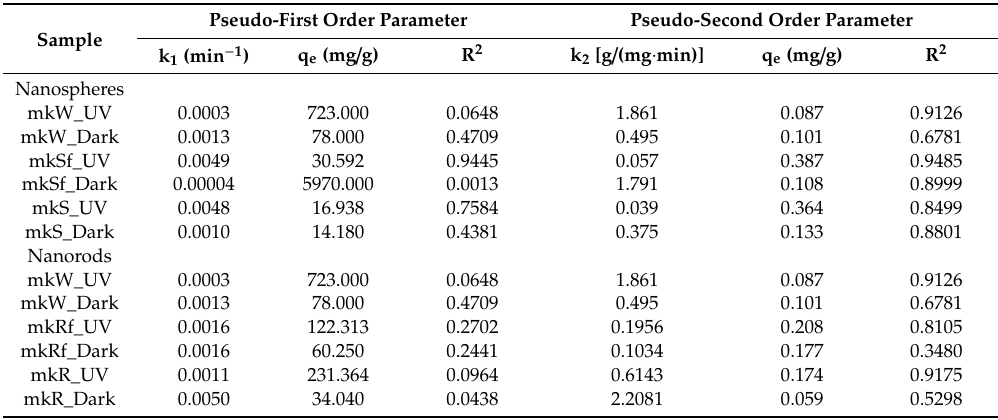
Table 3. Parameters of kinetics models for the adsorption of MB on metakaolin-based alkaline cement with and without ZnO